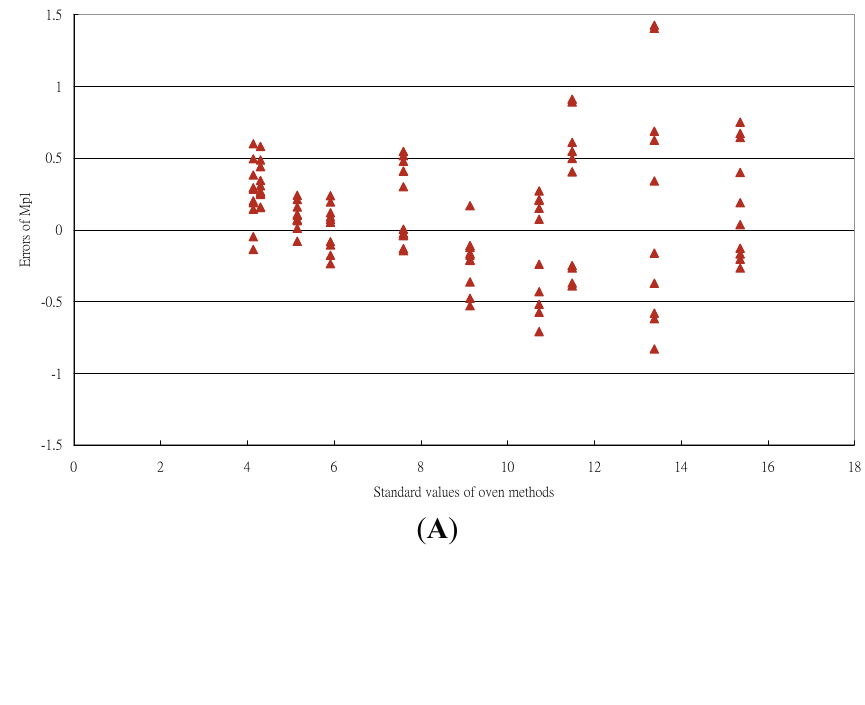
Figure 6. Error distribution of moisture measurements, calculated by three M ( A ) the M equation; ( B ) the M p1